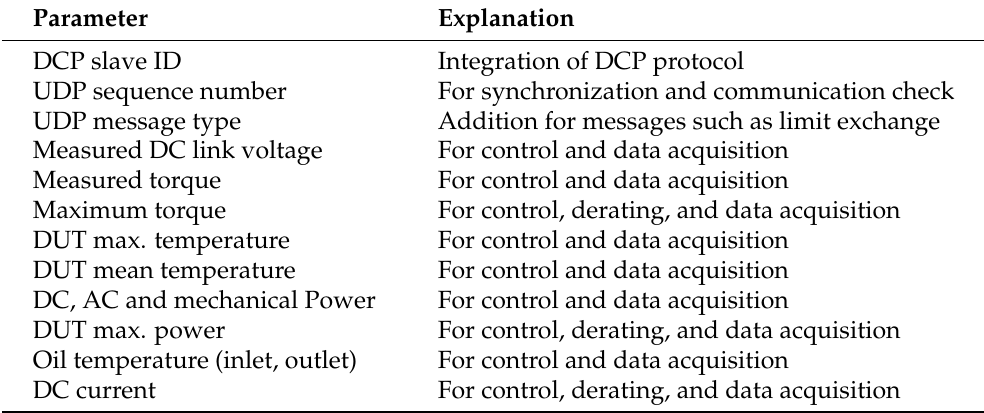
Table 6. Data sent from the EM test bench (slave) to the ICE test bench (master).